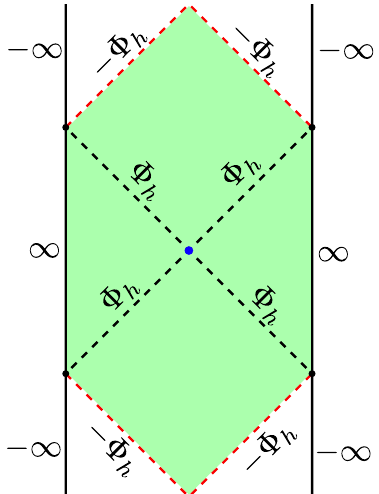
Figure 2 . The dilaton pro(cid:12)le in the wormhole solution of Jackiw-Teitelboim gravity. Between the two vertical black lines the geometry is global AdS 2 , and we indicate the value of the dilaton on various surfaces. In Reissner-Nordstrom language, the dashed black lines where (cid:8) = (cid:8) h are the \outer horizon", while the dashed red lines where (cid:8) = (cid:0) (cid:8) h are the \inner horizon". The dynamical problem with boundary conditions (2.6) is well-de(cid:12)ned only in the shaded green region. If we assume that the inner horizon is singular, this solution describes a wormhole connecting two asymptotically-AdS